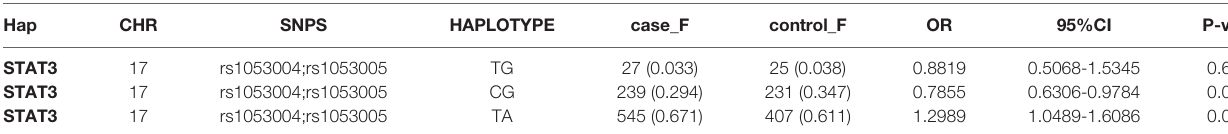
TABLE 4 | The association of haplotypes with the risk of tuberculosis.